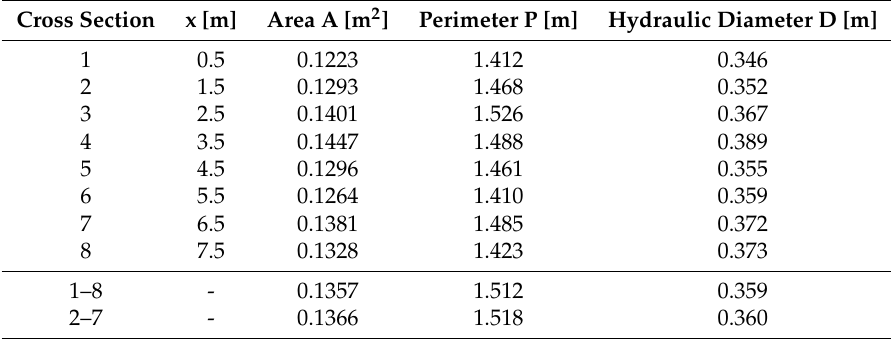
Table 1. Distance x to the beginning of the tunnel, cross-sectional area, wetted perimeter, and hydraulic diameter of the measurement cross sections (see Figure 3) and reach averaged values for the total and reduced model length.